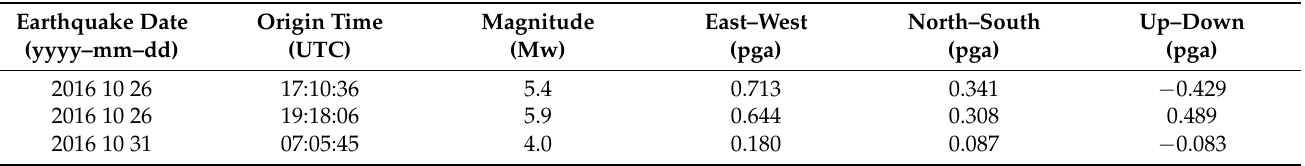
Table 2. Max PGA (% g) recorded by the accelerogram of the Campi Station in the three main directions for different seismic events. The minus signs of the last column highlight the upward seismic